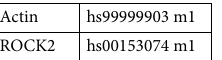
Table 3. PCR primers